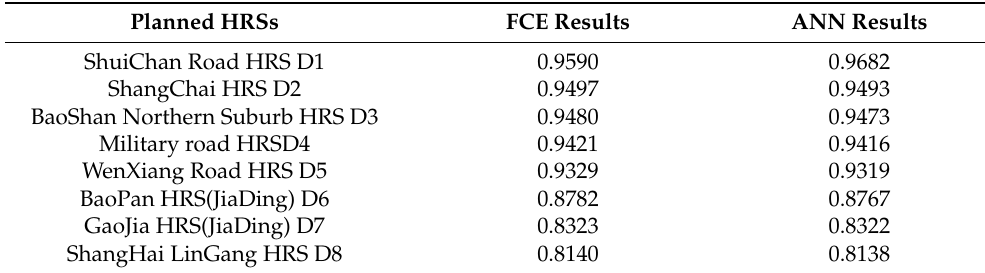
Table 12. Comparison table of predicted sample results. Planned